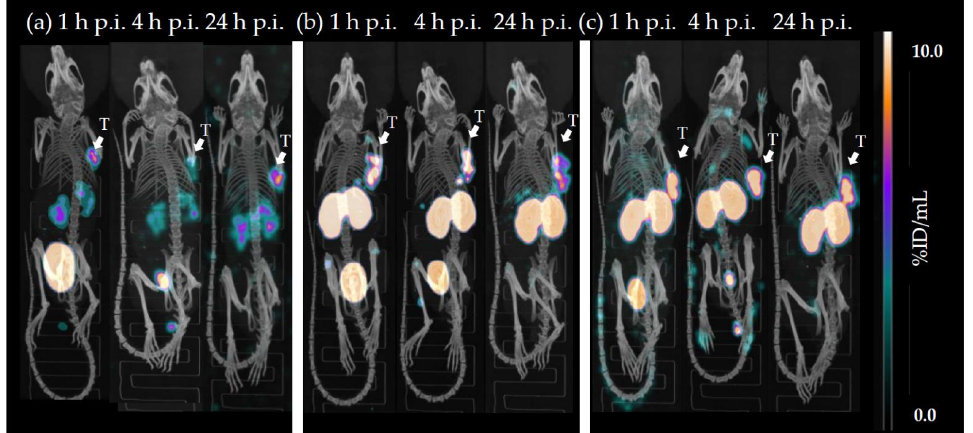
Figure 5. Representative µ SPECT/CT images of ( a ) [ 177 Lu]Lu-DOTA-PP-F11N, ( b ) [ 177 Lu]Lu- (R)- DOTAGA-rhCCK-9 and ( c ) [ 177 Lu]Lu- (R)- DOTAGA-rhCCK-16 at 1, 4 and 24 h p.i. in AR42J tumour- bearing CB17- SCID mice (100 pmol each). Tumours (T) are indicated by white arrows. CCK-2R specificity of [ 177 Lu]Lu-( R )-DOTAGA-rhCCK-16 was evaluated via co-injec- tion of an excess of the CCK2R-targeted compound, [ nat Lu]Lu-DOTA-MGS5, which re- sulted in activity levels in the tumour <1%. Activity levels in the stomach, which endoge- nously expresses the CCK-2R, were found to be <0.3% (Figure S4, Table S4). 3. Discussion Among the currently most promising minigastrin-derived peptides for clinical appli- cation (DOTA-MGS5, DOTA-PP-F11N and CP04), there is no option available for facile 18 F-labelling [20 – 23]. Particularly a 18 F-labelled minigastrin analogue would be beneficial for the detection of small MTC-derived metastases due to the low tissue penetration and thus high resolution of fluorine-18, consequently to its low positron energy ( E β,max = 635 keV), compared to gallium-68, for example [24]. Furthermore, up to now there is no CCK- 2R-targeted ligand that enables both 18 F- and 177 Lu-labelling. This radiohybrid-based con- cept has been successfully implemented for PSMA inhibitors and resulted in impressive results over the last three years, which is why the compounds rhPSMA-7.3 and rhPSMA- 10.1 are evaluated in clinical studies [13,25 – 32]. With the aim to develop a 177 Lu-labelled minigastrin analogue, which can also be labelled with fluorine-18, we introduced the lip- ophilic SiFA moiety into different sites within the highly hydrophilic, N -terminal D-glu- tamate chain of DOTA-PP-F11N and compared these novel compounds to the reference compounds, [ 177 Lu]Lu-DOTA-PP-F11N and [ 177 Lu]Lu-CP04. The SiFA moiety was introduced into different sites within both an α -linked poly-D- glutamate chain (= ( R )-DOTAGA-rhCCK-1 to -9) and a γ -linked poly-D-glutamate chain (= ( R )-DOTAGA-rhCCK-10 to -18), while the binding sequence of DOTA-PP-F11N was maintained. In general, for both linker concepts it could be observed that with increasing distance of the SiFA moiety to the binding motif, CCK-2R affinity was enhanced, which indicates that the bulky SiFA building block does not fit into the binding pocket of the receptor. However, at a farther distance the SiFA group seems to be located outside of the binding pocket and thus CCK-2R affinity increases. In direct comparison of these series of minigastrin derivatives ( α - or γ -linked D-glutamate chain) that each exhibit the same site for the SiFA moiety, it is evident that those ligands containing a γ -linked D-glutamate